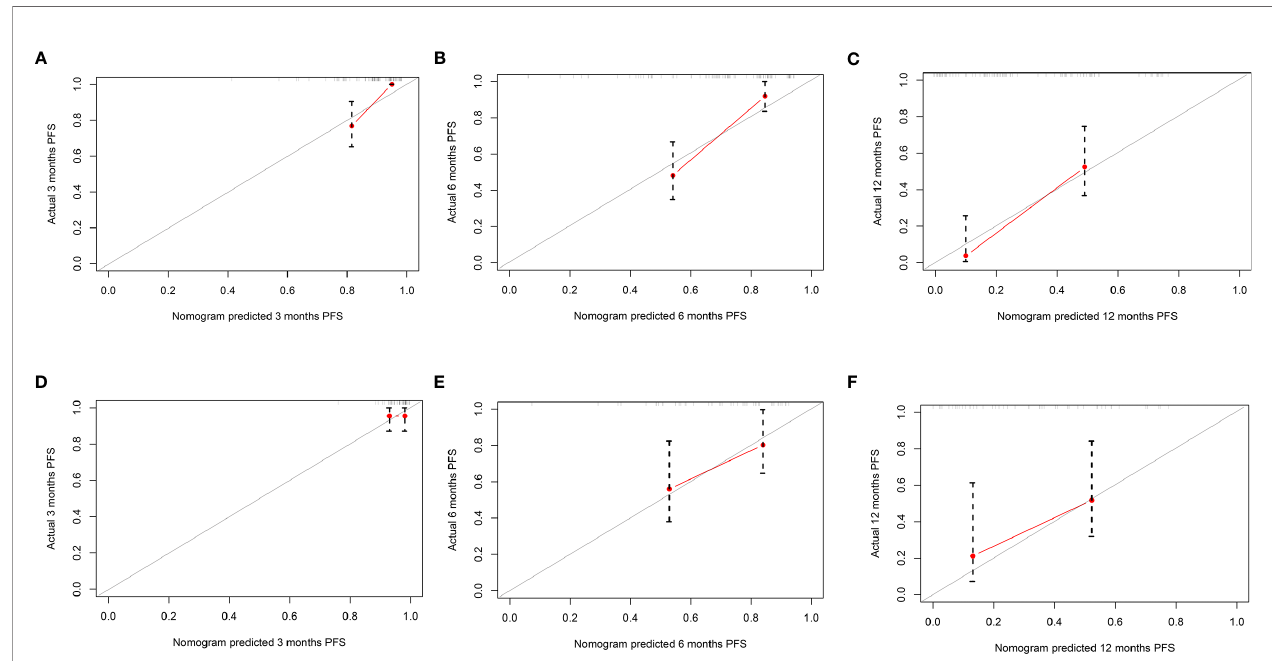
FIGURE 5 | The calibration curves of the nomogram for predicting progression-free survival (PFS) in both the training and validation cohorts. The x-axis represents the nomogram predicted probability, and the y-axis represents the actual probability of PFS. The red line indicates the performance of the nomogram, of which a closer fi t to the gray line represents a better prediction. Calibration curves of the nomogram for predicting PFS at (A) 3, (B) 6, and (C) 12 months in the training cohort. Calibration curves of the nomogram to predict PFS at (D) 3, (E) 6, and (F) 12 months in the validation